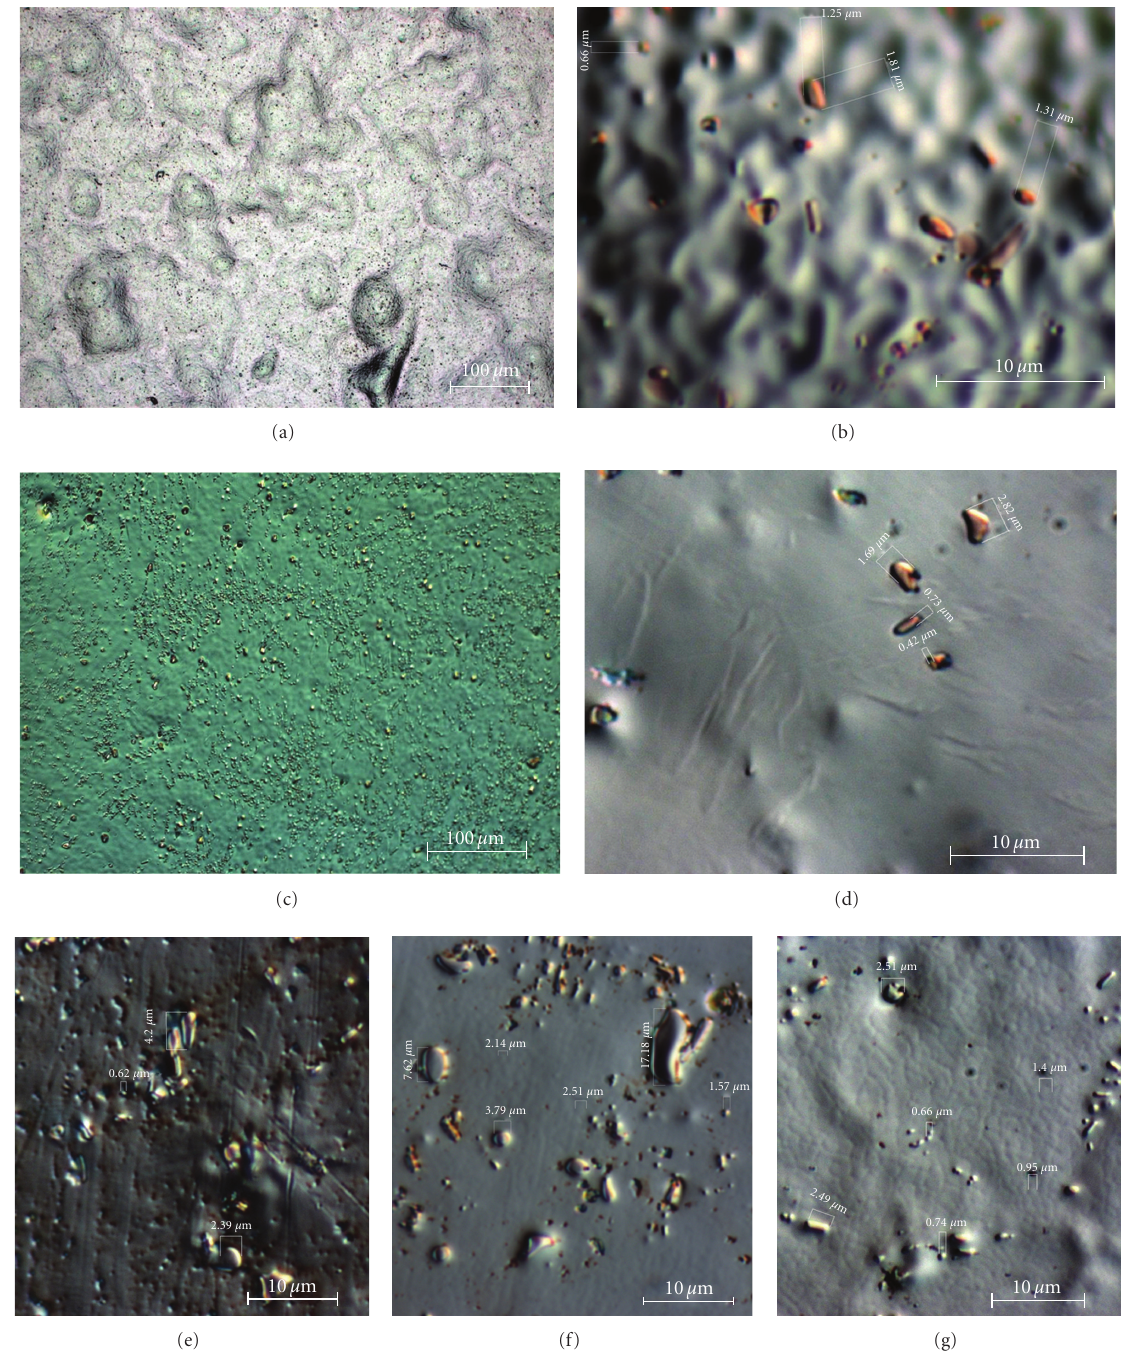
Figure 5: Optical images of the NiTi specimen surface after di ff erent types of treatment (Table 1): chemical etching with subsequent electropolishing (a)-(b), high-luster mechanical polishing with subsequent electropolishing (c)-(d), and ion modifications of the NiTi-B specimens with Zr ions (e), Ti ions (f), and Si ions (g) of fluence (in all cases) D = 2 × 10 17 cm − 2 .